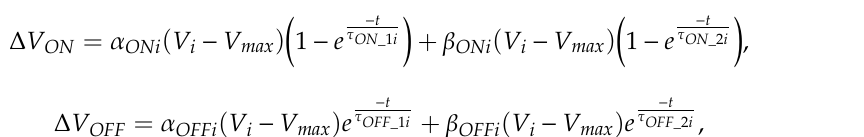
Figure 7. PMS voltages for LICEF C-03 when a constant noise source is introduced. In green, the status of the heater is depicted. Red crosses for the PMS voltage indicate that the heater is on and blue crosses show when the heater is off.